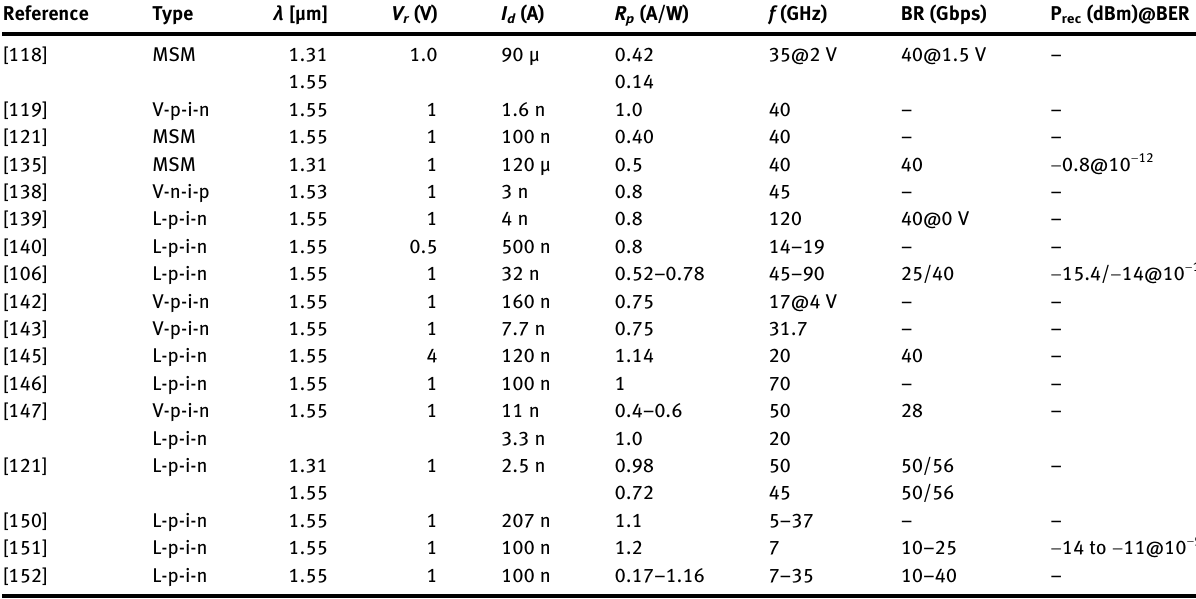
Table  : Summary of state-of-the-art waveguide-integrated Si – Ge photodetectors operating at standard communication wavelengths.